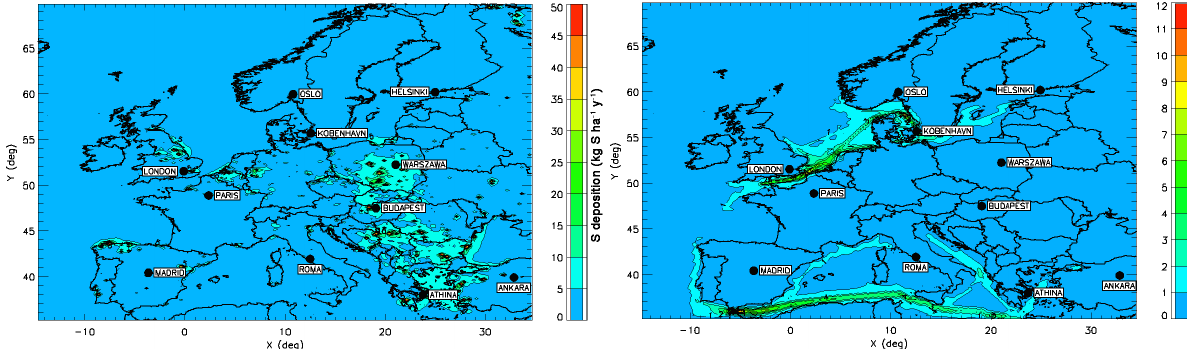
Figure 10. Sulfur deposition only due to land-based emissions (left) (no ship) and due to ship emissions (right) (base case − no